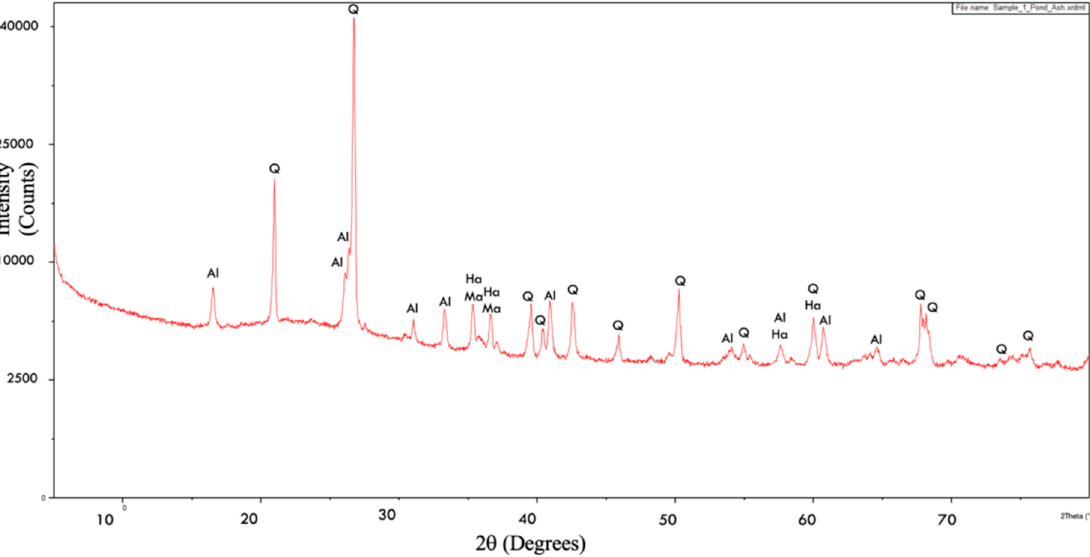
Figure 2. XRD di ff ractogram for Pond ash. Figure 2. XRD diffractogram for Pond ash. Figure 2. XRD diffractogram for Pond ash.